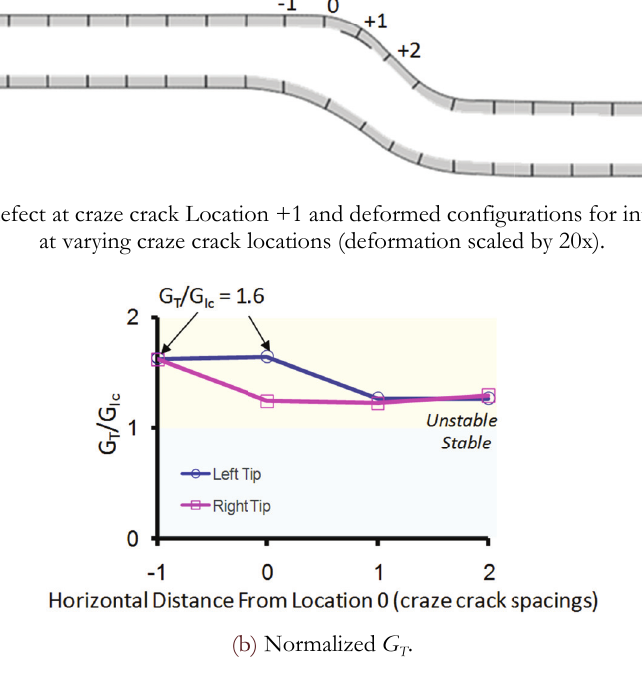
G T value, for ables is discu